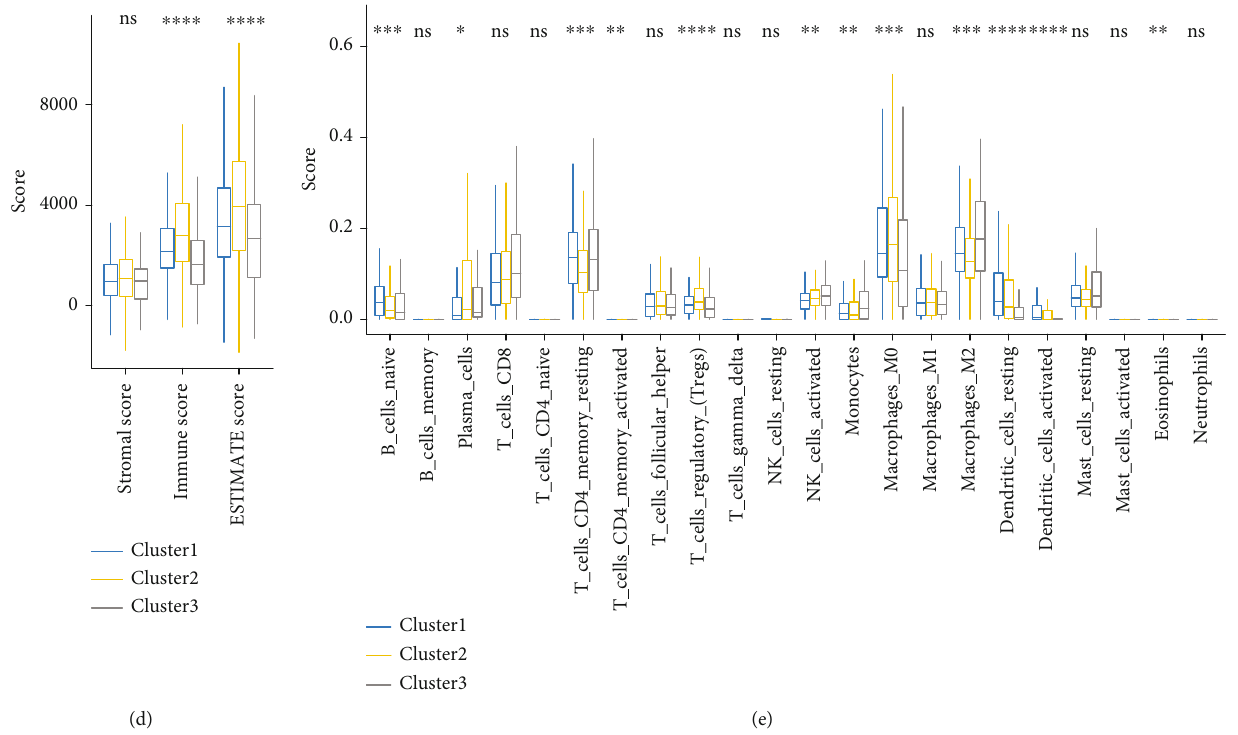
Figure 2: Molecular subtypes were identi fi ed by multi-omics analysis. (a) KM curves for disease-free survival of 3 molecular subtypes. (b) A Venn diagram for the top 20 genes showing the highest mutations in each molecular subtype. (c) Heat maps of the top 20 genes with the highest mutations in each molecular subtype. (d) The distribution of immune in fi ltration microenvironment scores of the three subtypes was di ff erent. (e) Distribution di ff erence of three subtypes in 22 immune cell in fi ltration scores. Table 2: Di ff erential expression of PCG and lncRNA.